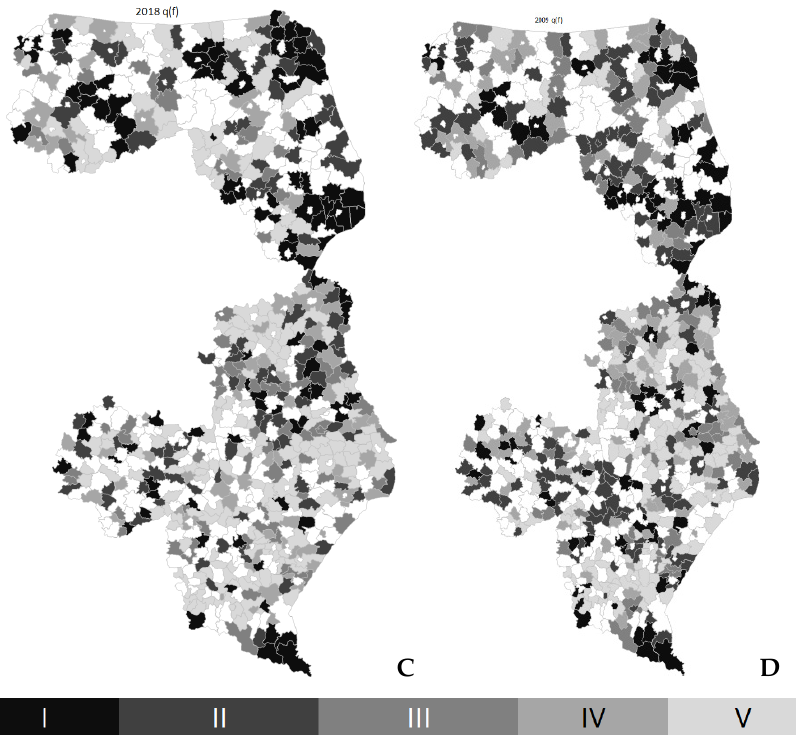
Figure 1. Synthetic measure of the financial situation of rural communes in eastern Poland in 2009 and 2018. Source: own research. q (r) development measure ( A 2009, B 2018); q (f) financial situation measure ( C 2018, D